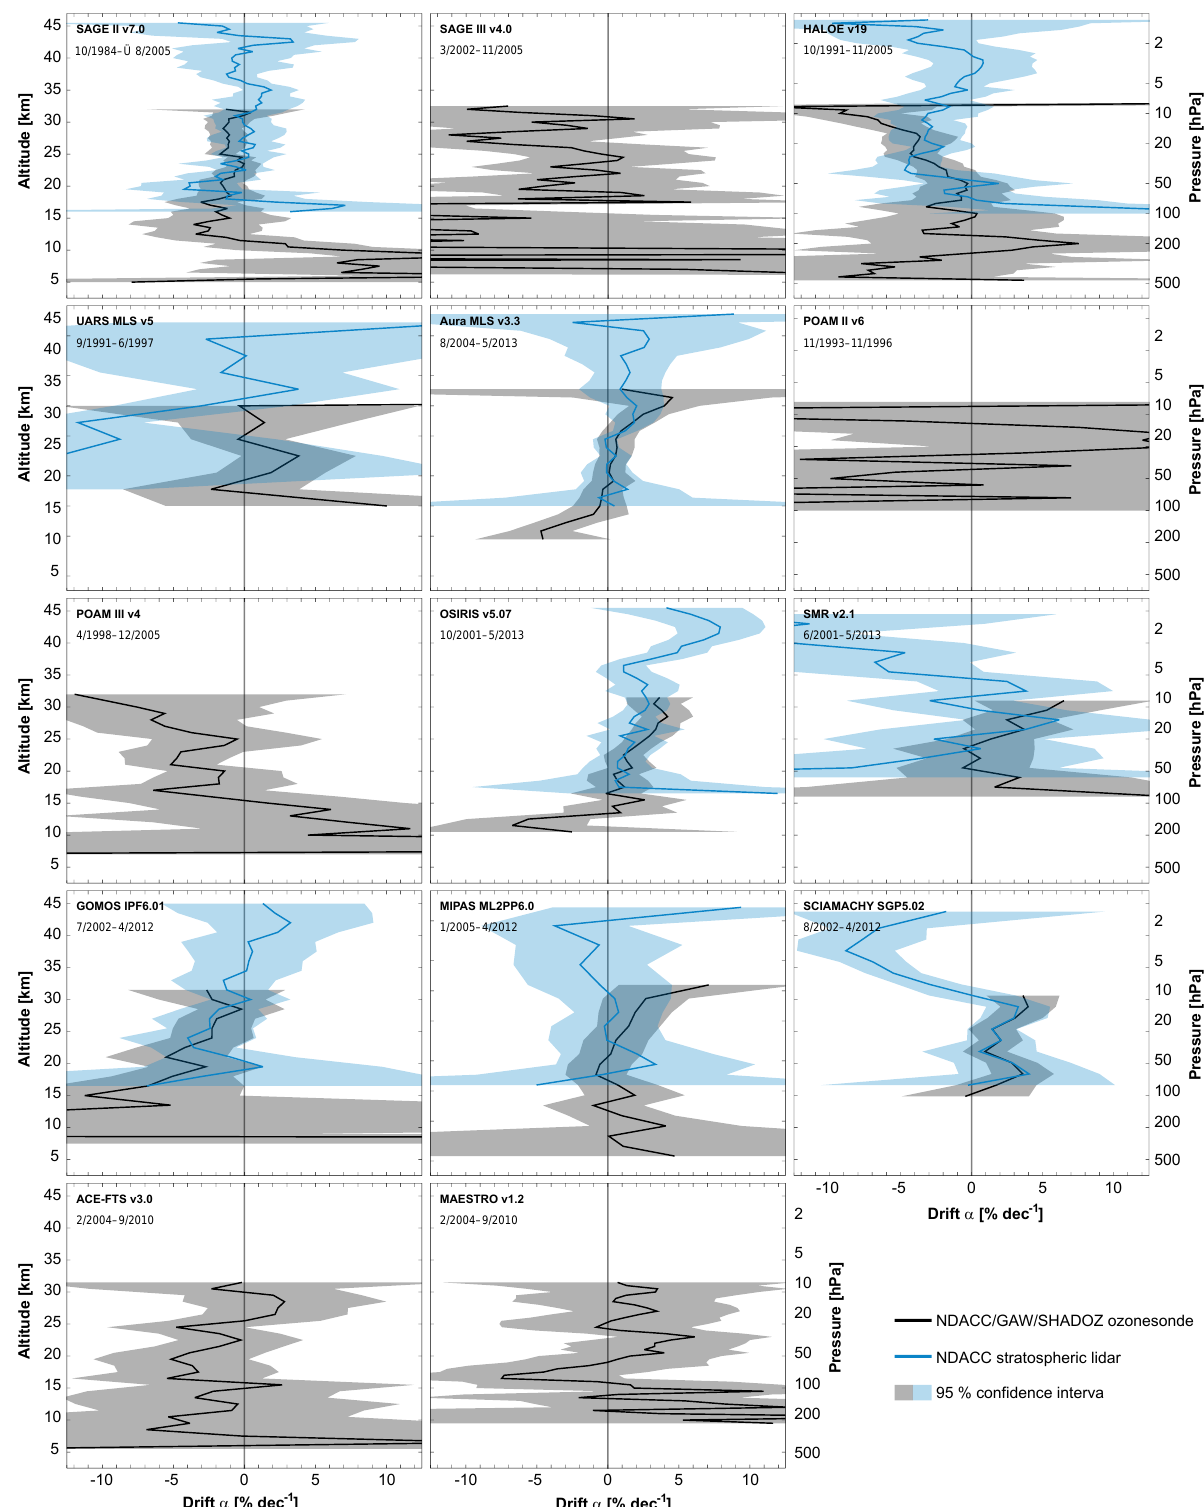
Figure 5. Average drift ¯ α of each satellite record relative to the entire ozonesonde (black) and lidar network (blue). The shaded region indicates the χ 2 -adjusted 95% confidence interval for the drift. The analysis is performed in the native profile representation of each satellite record. Y -axis tick marks correspond to the native vertical coordinate of the satellite record and may be offset from the axis labels in case the coordinate